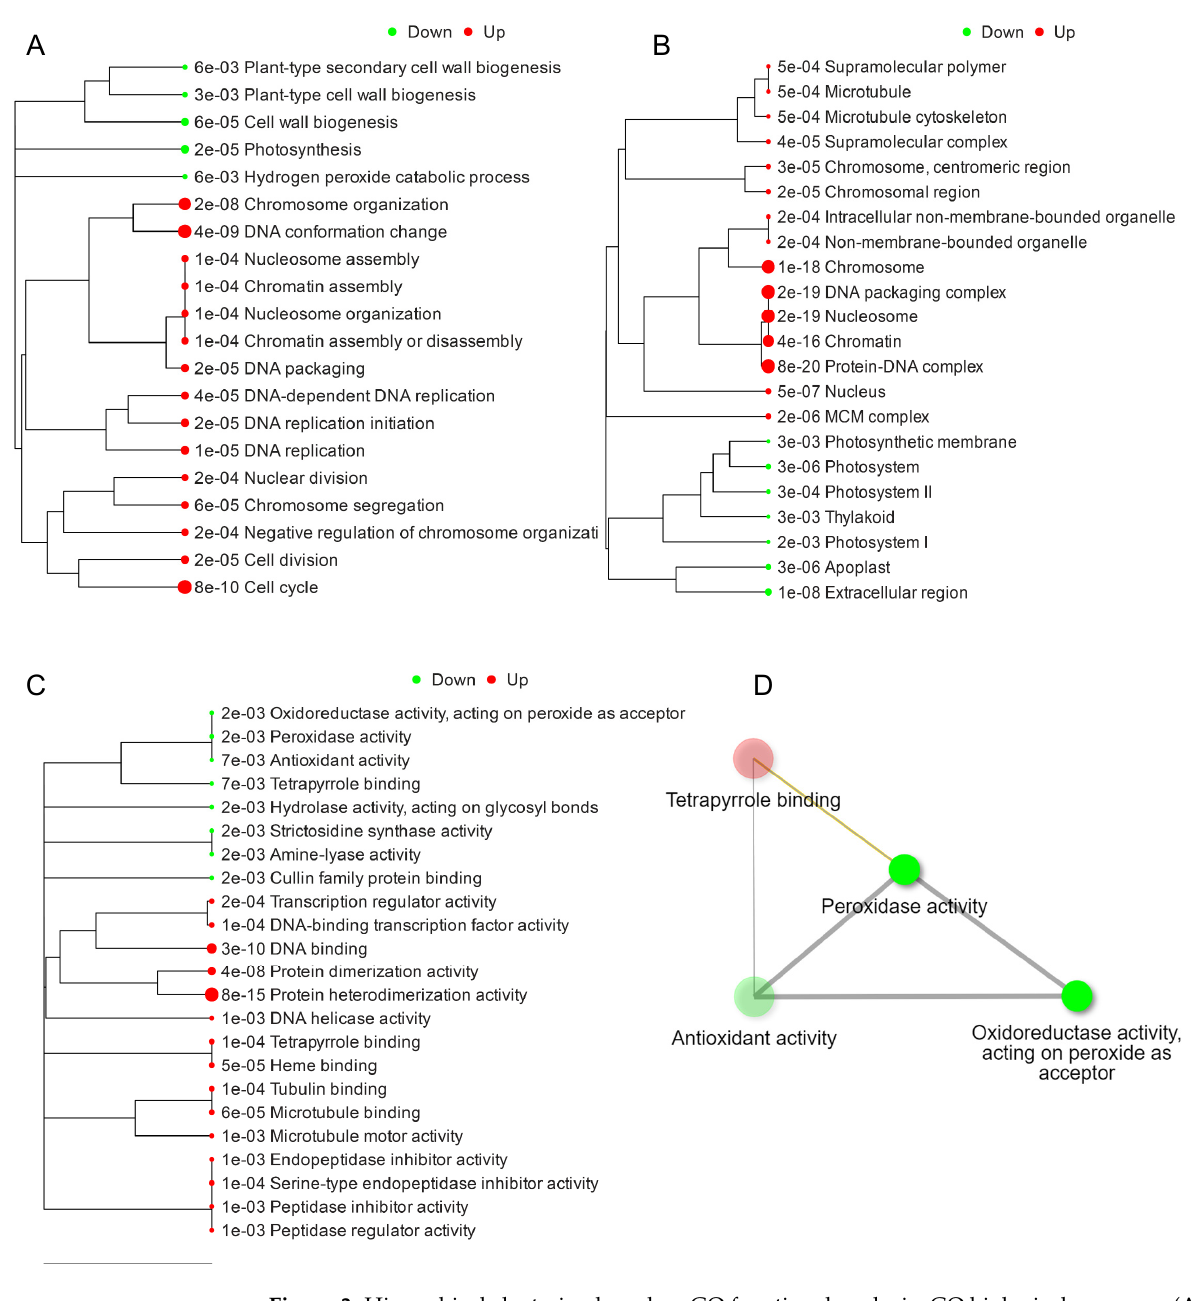
Figure 3. Hierarchical clustering based on GO functional analysis. GO biological processes ( A ); GO cellular processes ( B ); GO molecular functions associated with DEGs ( C ); and GO terms network interaction analysis of DEGs ( D ). DEGs were subjected to design hierarchical clustering trees using iDEP 0.951, with parameters: most variable genes to include—2000, number of clusters—4, and normalize by gene—mean